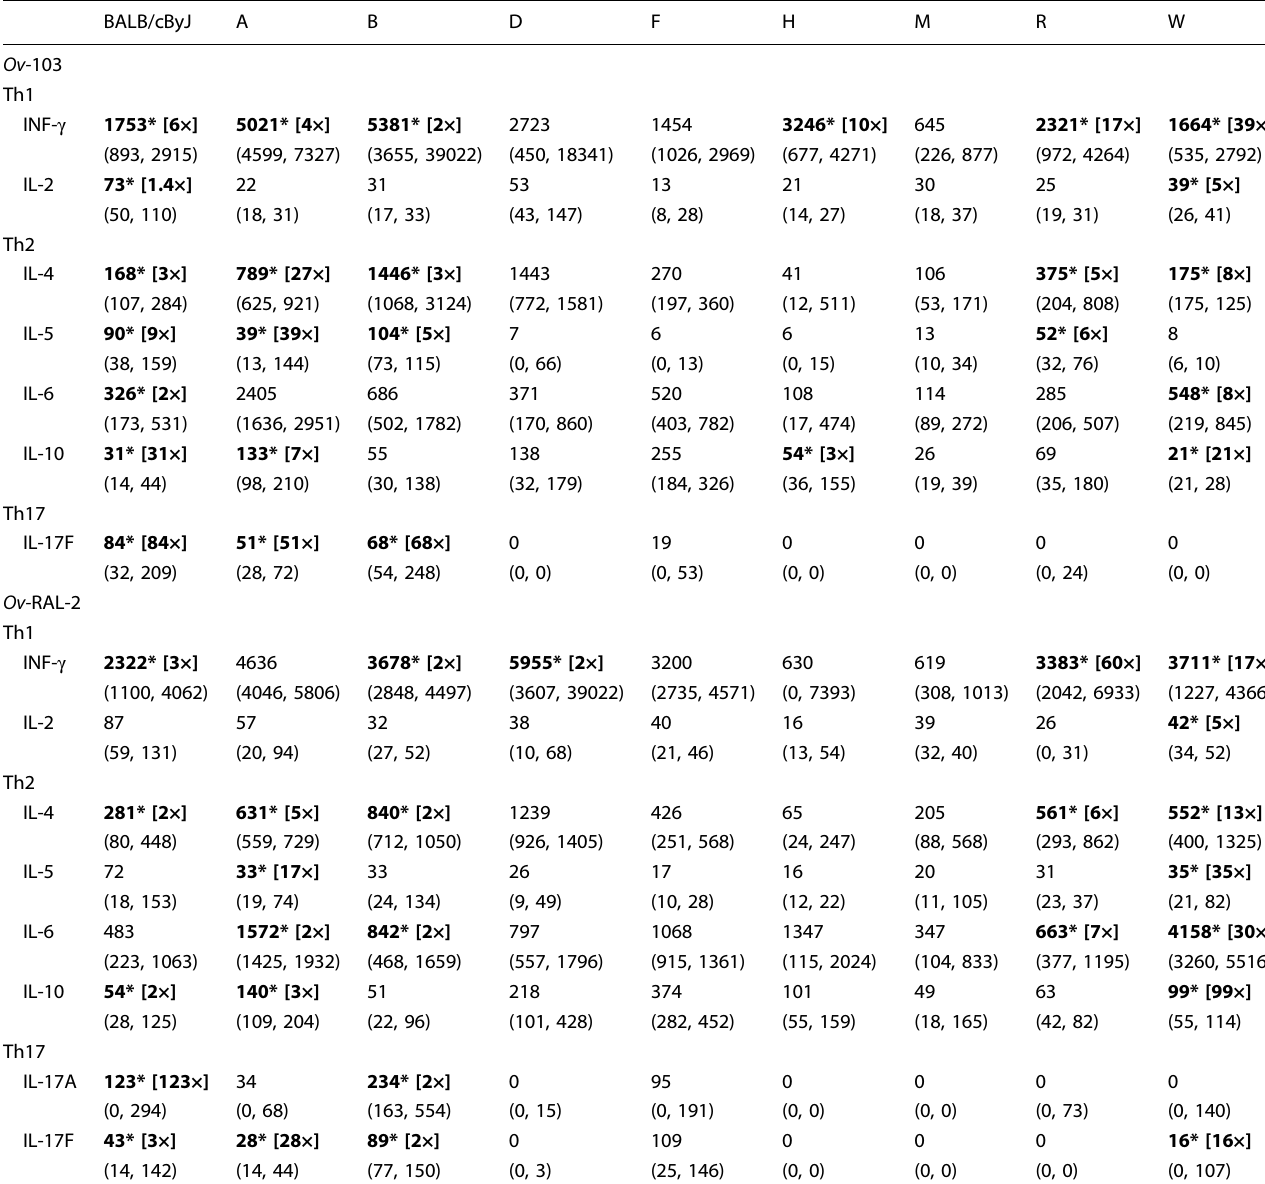
Table 4. Cytokine pro fi les in supernatants from ex vivo antigen-stimulated spleen cells recovered from BALB/cByJ and 8 CC-RIX Lines. BALB/cByJ A